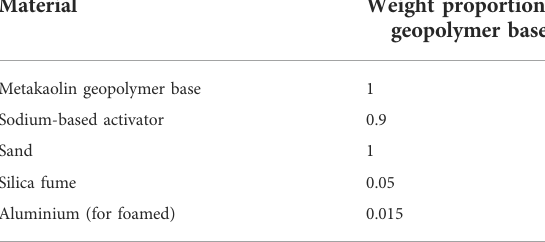
TABLE 1 Metakaolin composition (MEFISTO L05, 2022)